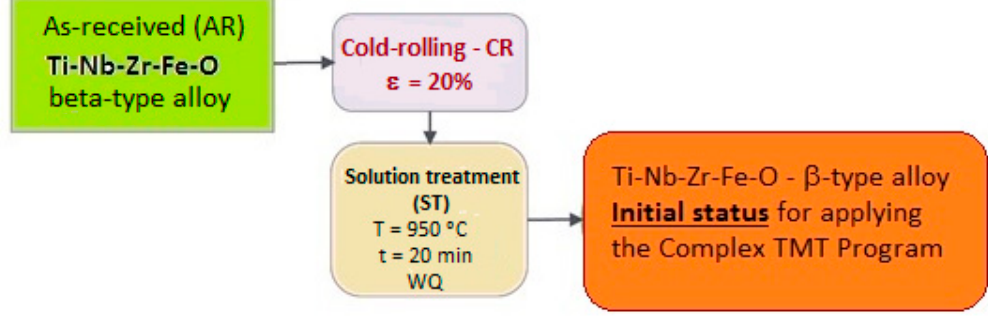
Figure 1. Schema for processing the as-cast sample to obtain a quality homogenised precursor named the initial alloy.